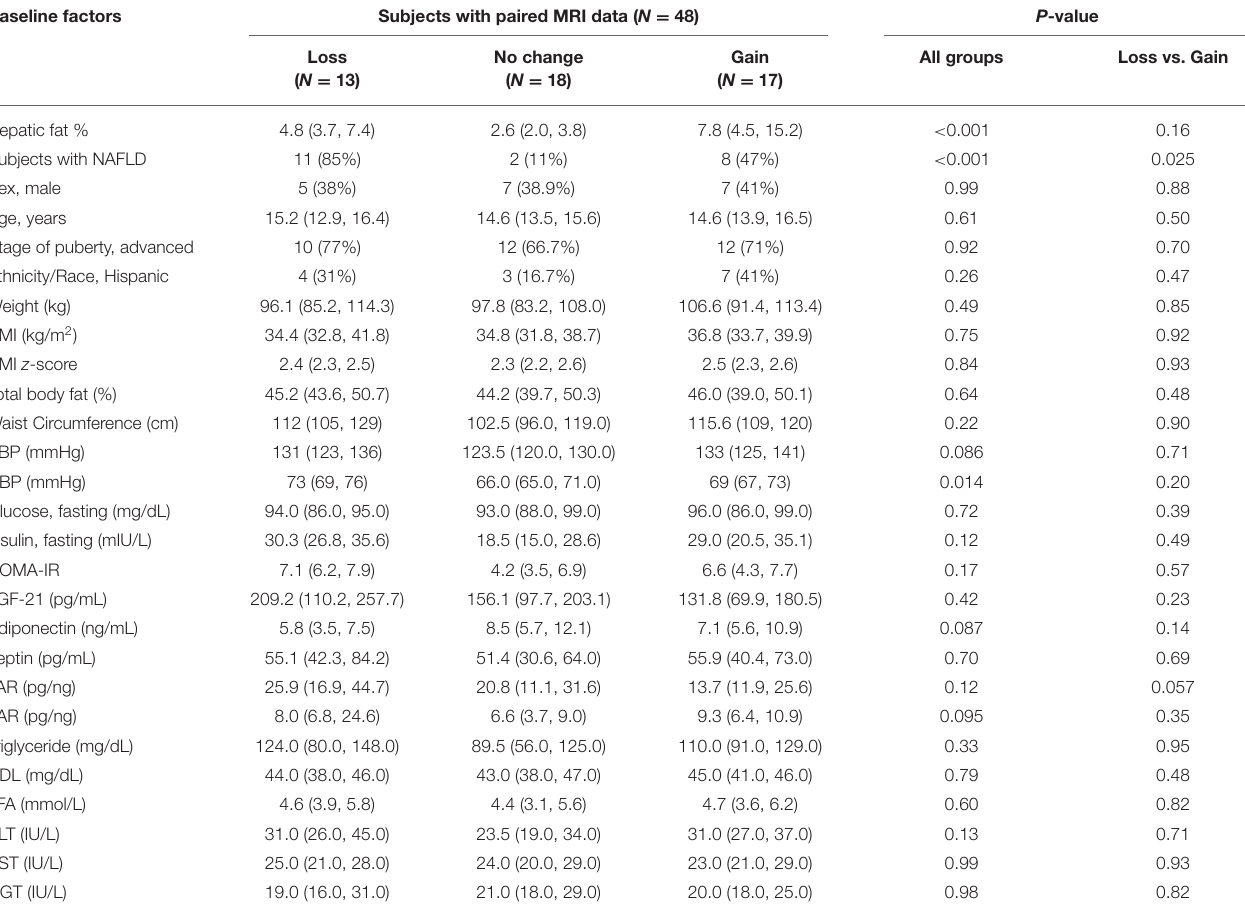
TABLE 2 | Summary and comparison of baseline characteristics between loss, no change, and gain groups. Baseline